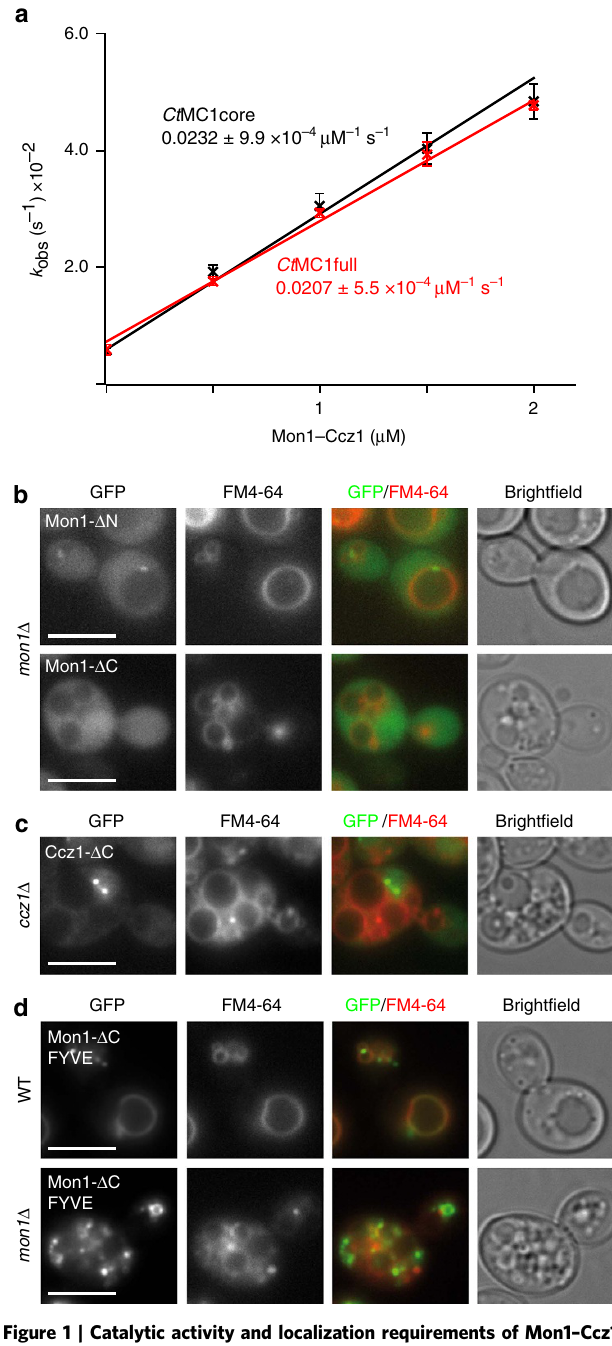
Figure 1 | Catalytic activity and localization requirements of Mon1–Ccz1. ( a ) Nucleotide exchange rates of Ypt7 are plotted as a function of Ct MC1 concentrations. The catalytic efficiency of full-length Ct MC1 and a truncated Ct MC1core complex (Mon1 195–355, Ccz1 1–249) are comparable. Error bars represent s.d. of three independent biological repeats. ( b ) GFP-tagged truncations of Sc Mon1 and ( c ) Sc Ccz1 are introduced into mon1 D and ccz1 D yeast knockout strains. The N-terminus of Mon1 is dispensable, but deletion of the Mon1 and Ccz1 C-termini cause mislocalization and vacuolar fragmentation. ( d ) The C-terminus of Mon1 is replaced by a PI3P-binding FYVE domain and artificially recruited to endosomal and vacuolar membranes as seen in a wild-type background, but Mon1- D C-FVYE is not able to complement a mon1 D strain. Scale bars: 5 m